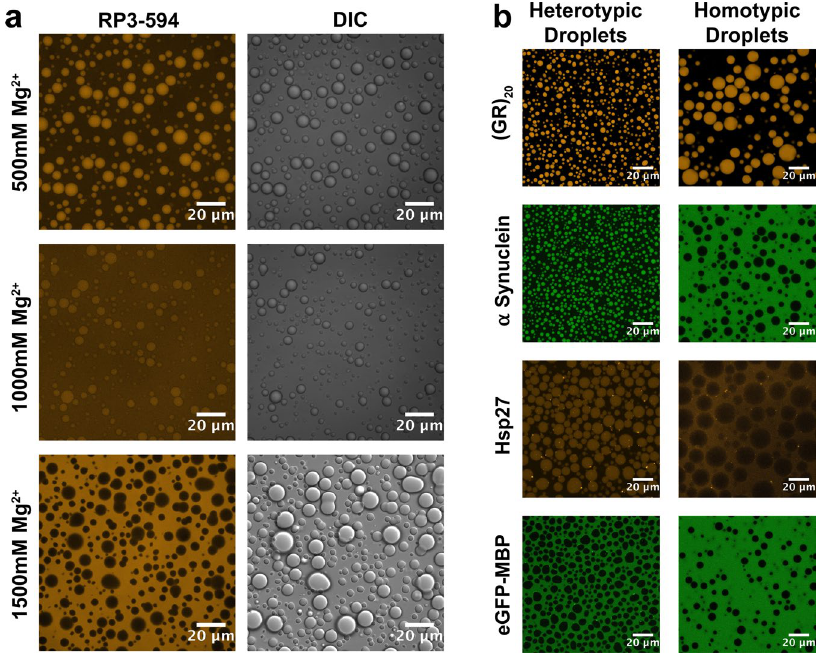
Figure 3. Heterotypic and homotypic droplets display distinct microenvironments. ( a ) Confocal fluorescence and DIC images of polyU droplets with RP3-594 as a fluorescent probe. (1.5 mg/mL polyU, 0.5 µ M RP3-AF594). ( b ) Confocal fluorescence images showing peptide/protein partitioning in heterotypic and homotypic RNA coacervates. (Left Panels: [RP3] = 500 µ M, 0.6x polyU wt/wt, 10 mM MgCl 2 - Right Panels: 1 mg/mL polyU, 500 mM MgCl 2 ) (Fluorescent probes: 0.5 µ M (GR) 20 -AF594, 0.5 µ M α -synuclein-AF488, 0.5 µ M Hsp27-AF594, 0.5 µ M